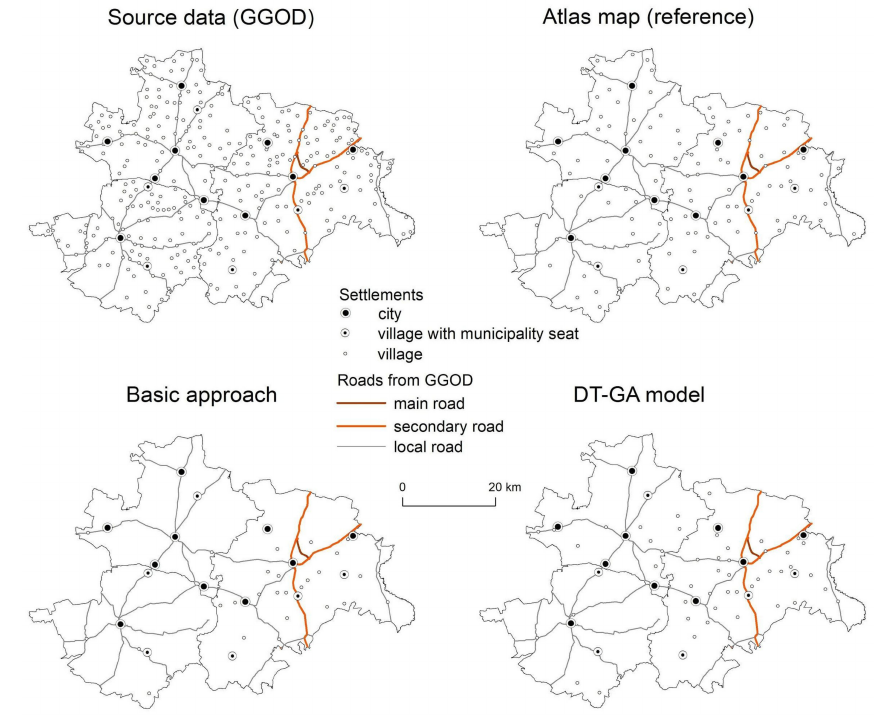
Figure 5. Maps of Krotoszy´nski, Ostrowski, Milicki and Złotoryjski districts; group 2.